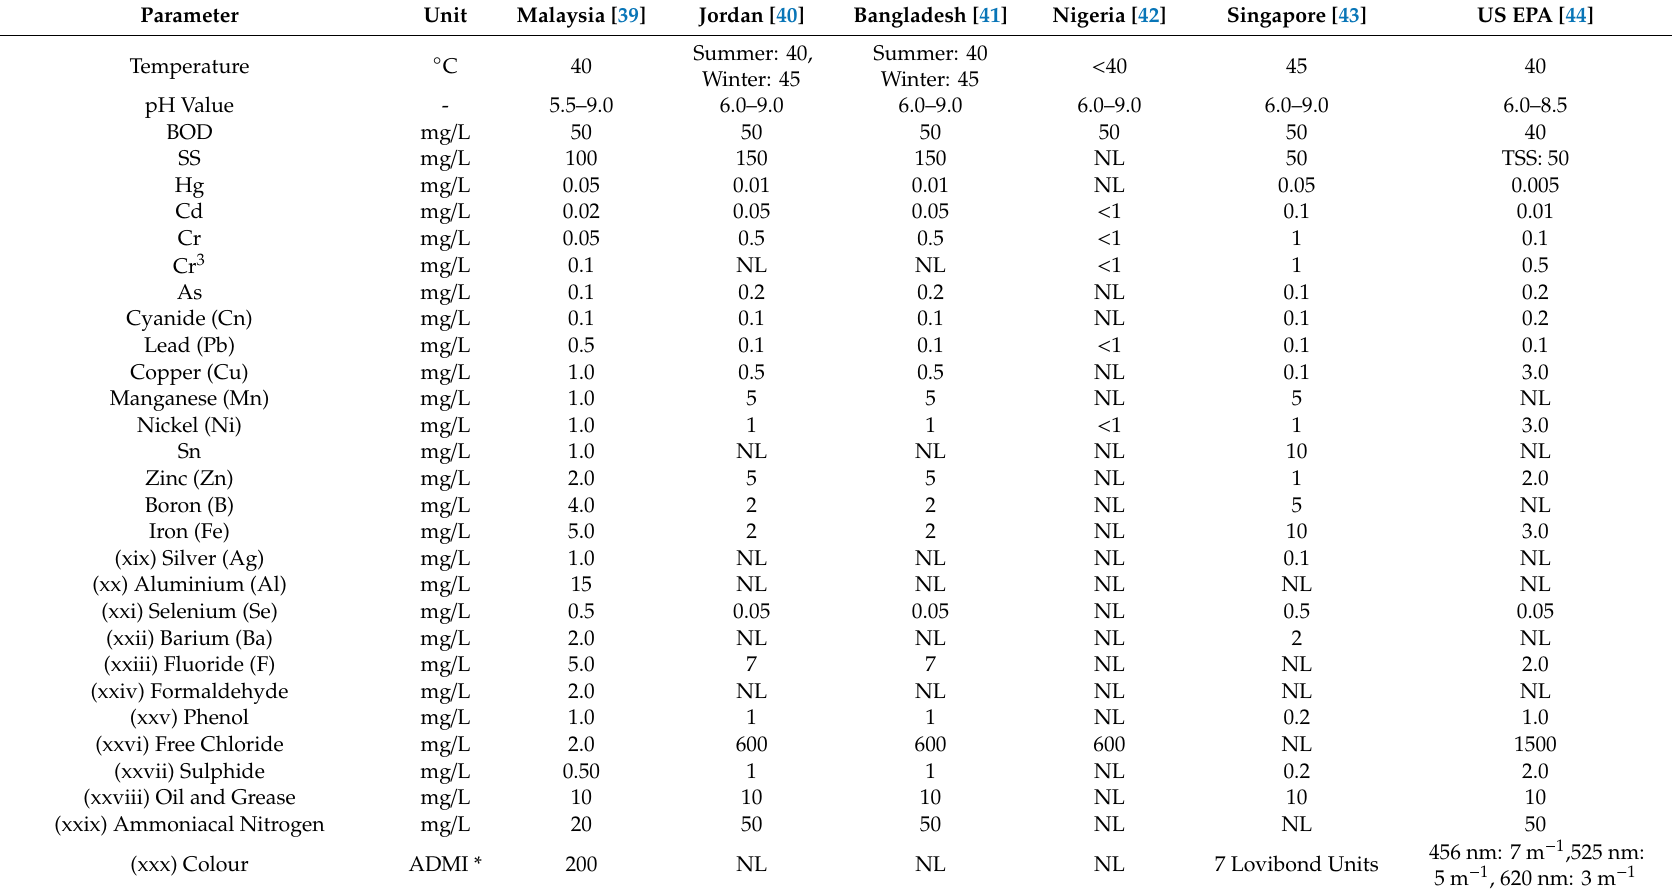
Table 4. Permissible standard limits for industrial wastewater in di ff erent